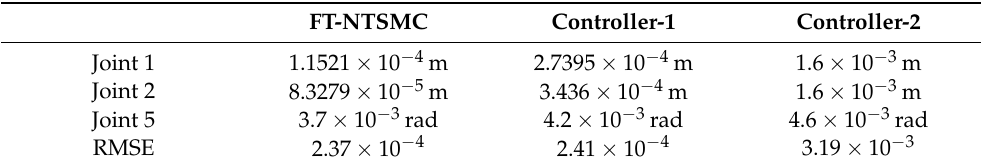
Table 3. Maximum steady-state error of the unilateral active joints and the RMSE under the three controllers.